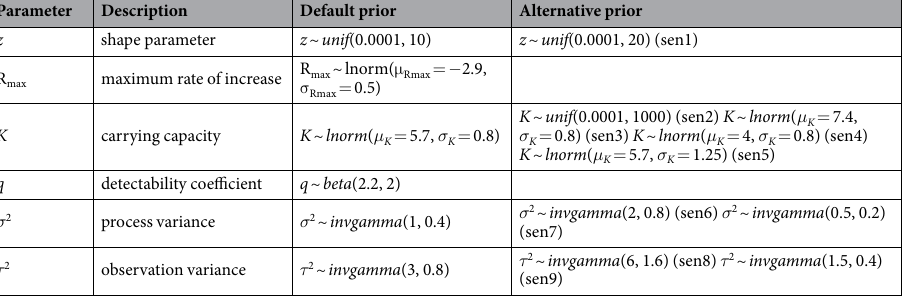
Table 5. Estimable parameters and prior specifications for Bayesian state-space models. Alternative prior specifications were considered in the sensitivity analyses